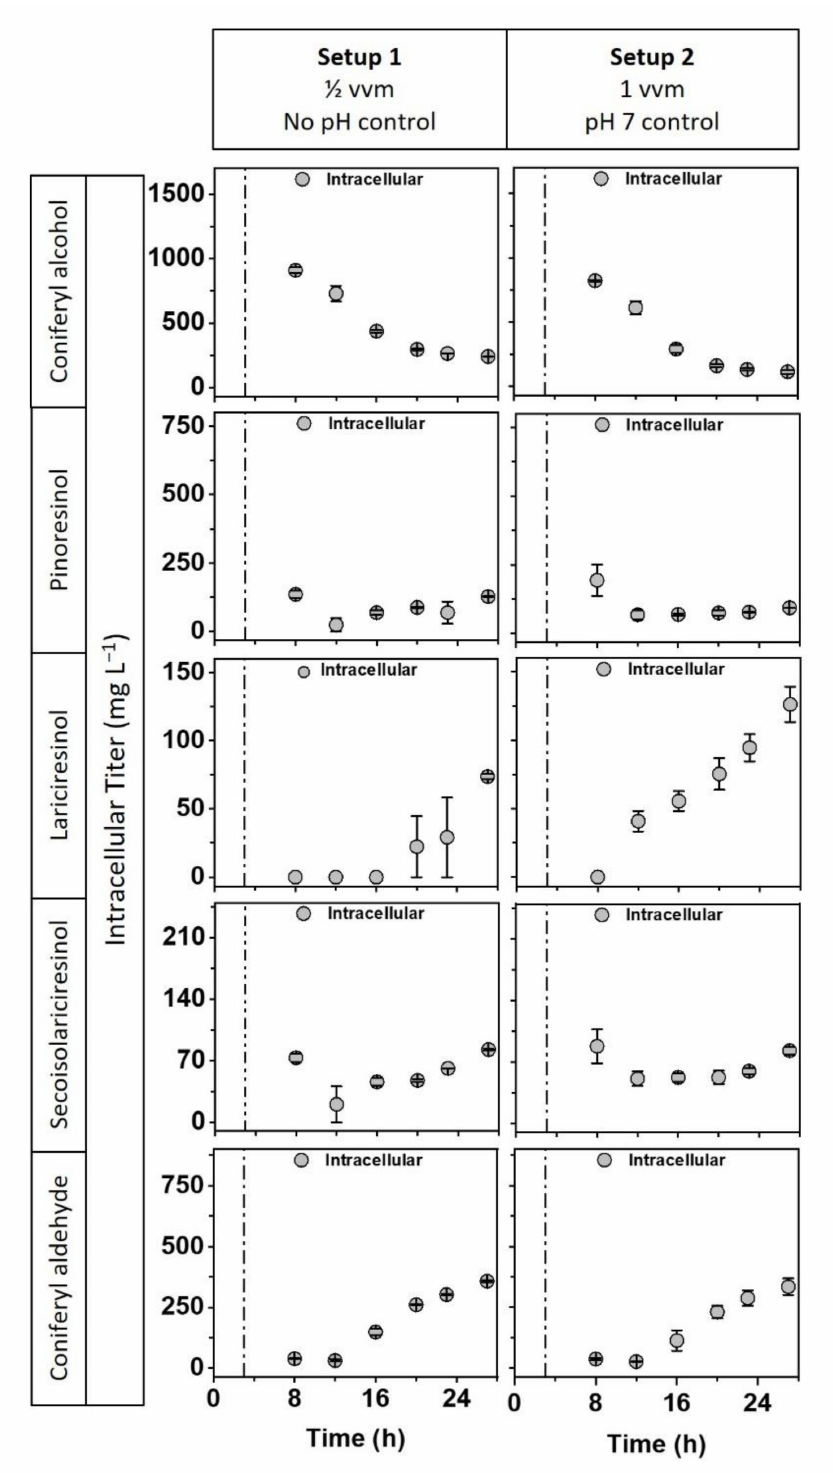
Figure 4. Testing of various STR process conditions for the production of SILR. E. coli C43(DE3) pCDFDuet_syfiPLR was cultivated at 37 ◦ C, 1000 rpm, in modified Riesenberg medium with 0.01% ( v / v ) AF204. At OD 600 0.6, 0.75 mM IPTG, 0.5 g L − 1 coniferyl alcohol, and 50 µ M CuSO 4 were added (indicated by pointed-dashed line). After induction, the cultivation temperature was reduced to 30 ◦ C. Cultivations were ended 24 h after induction. Bioreactor cultivations were aerated with 6 L h − 1 (0.5 volume gas per volume liquid per minute (vvm)) or 12 L h − 1 (1 vvm) compressed air. The pH of cultivations was either not regulated or was maintained at pH